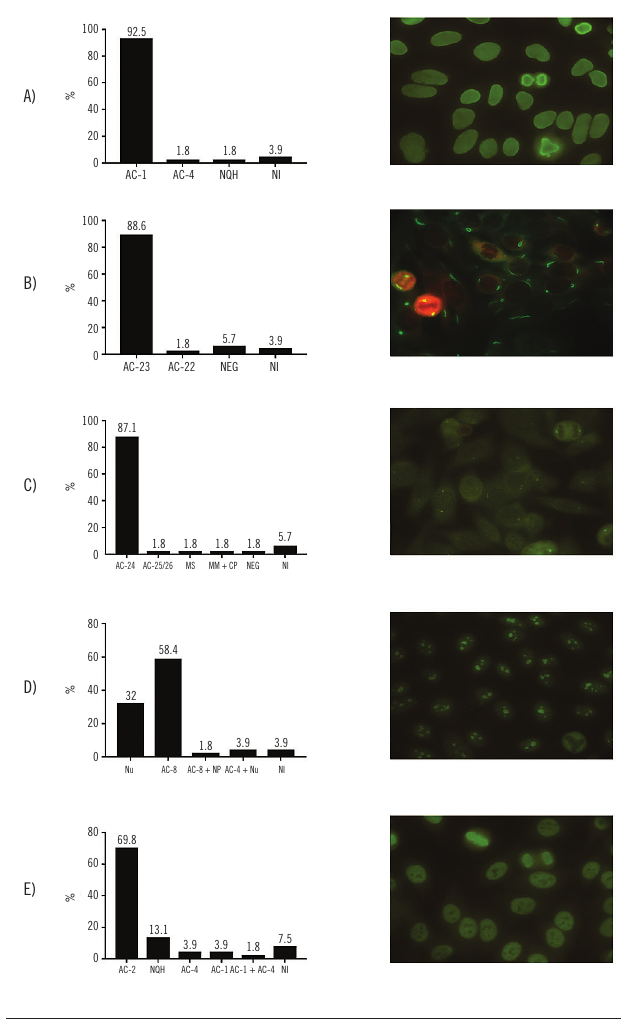
figurE 4 − Pattern images presented to study participants for classification, as recommended by the Brazilian Consensus AC-1: nuclear homogeneous pattern; AC-4: nuclear fine dot pattern; NQH: nuclear quasi- homogeneous pattern; NI: not informed; AC-23: cytoplasmic rings and rods pattern; AC-22: polar cytoplasmic pattern; NEG: negative results; AC-24: mitotic spindle centriole pattern; AC-25/26: mitotic spindle pattern NuMA-type; MS: mitotic spindle pattern; MM: mixed mitotic spindle pattern; CP: cytoplasmic dot pattern; Nu: Nucleolar pattern; AC-8: nucleolar homogeneous pattern; NP: nuclear dot pattern; AC-2: nuclear dense fine dot